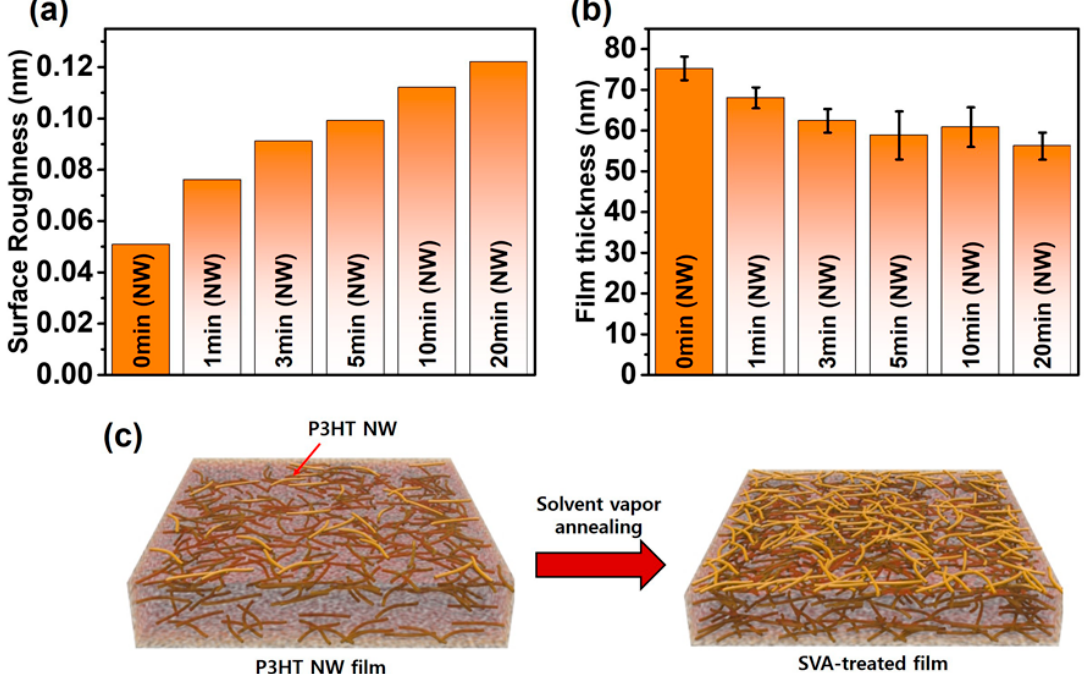
Figure 3. ( a ) Surface roughness and ( b ) film thickness of P3HT-NW films annealed by CF vapor for different times (0, 1, 3, 5, 10, and 20 min). ( c ) Schematic illustration of the influence of solvent vapor annealing (SVA) on the morphology of P3HT films. The colored line depicts the P3HT